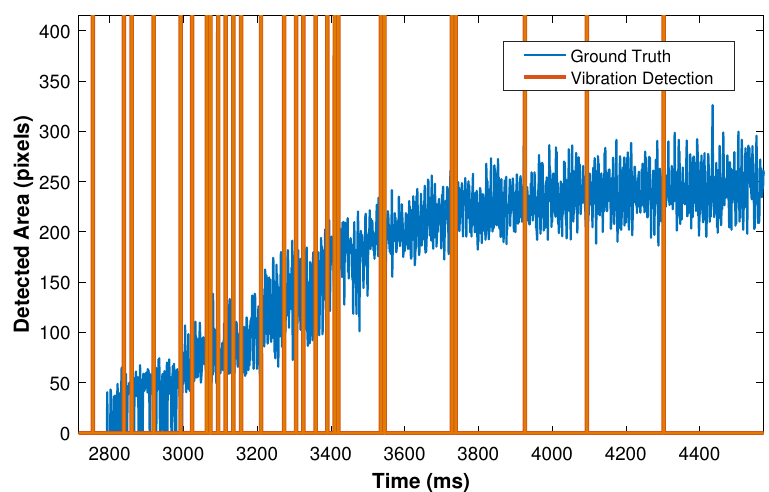
Figure 14. Detection of vibration incidents during grasping